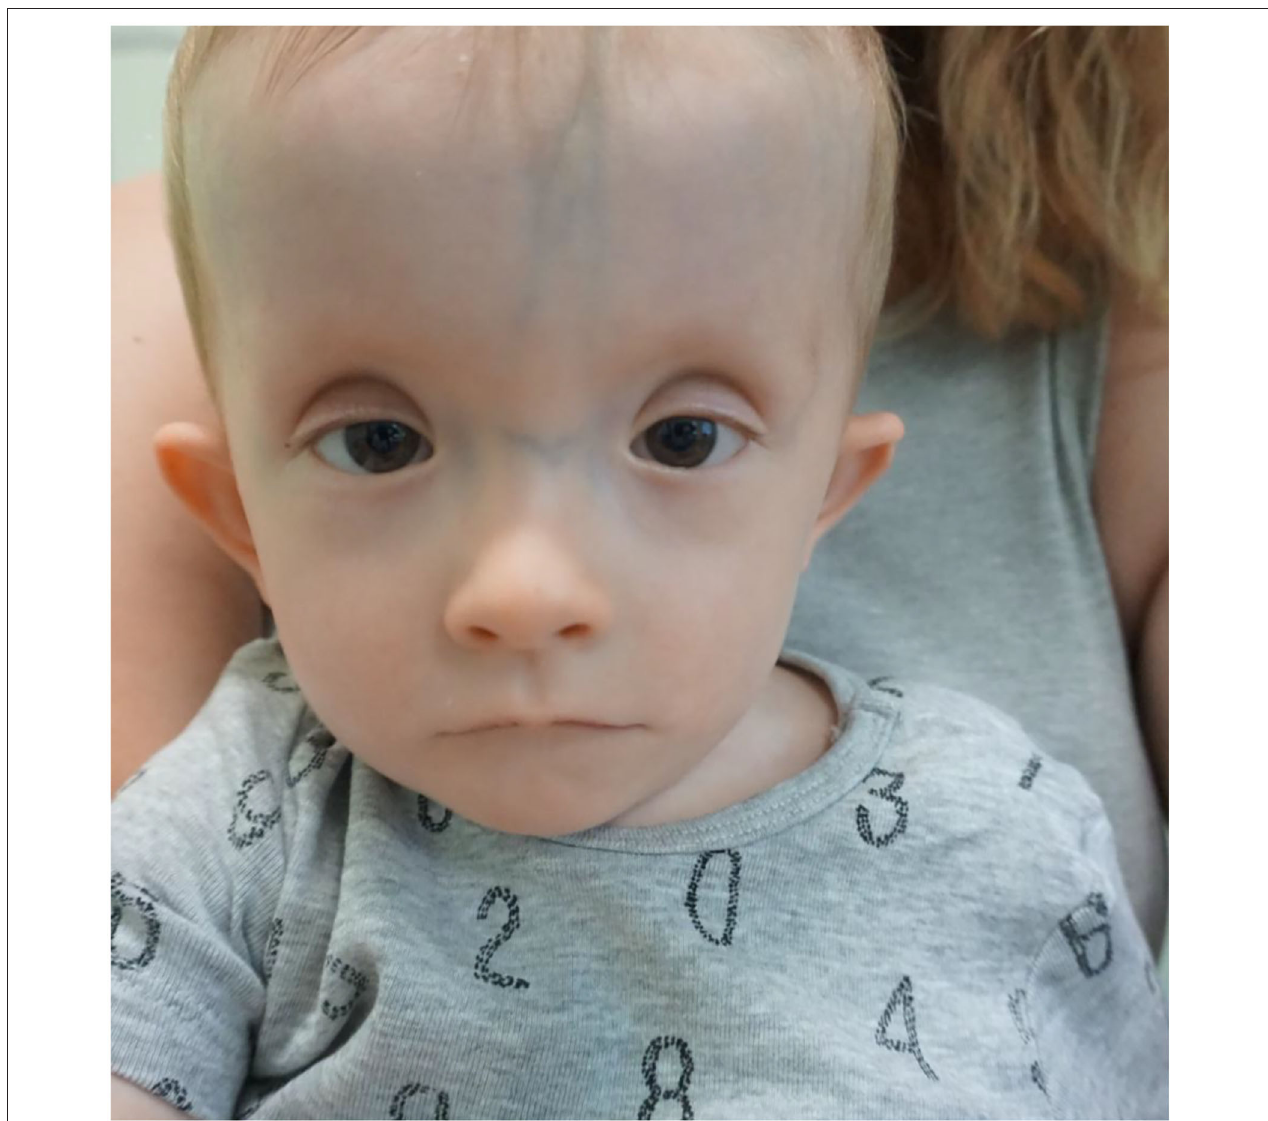
FIGURE 2 | The facial phenotype of Case 2 and 16 months. Not the high and broad forehead, flat nasal bridge, short palpebral fissures and ptosis, thin lips.